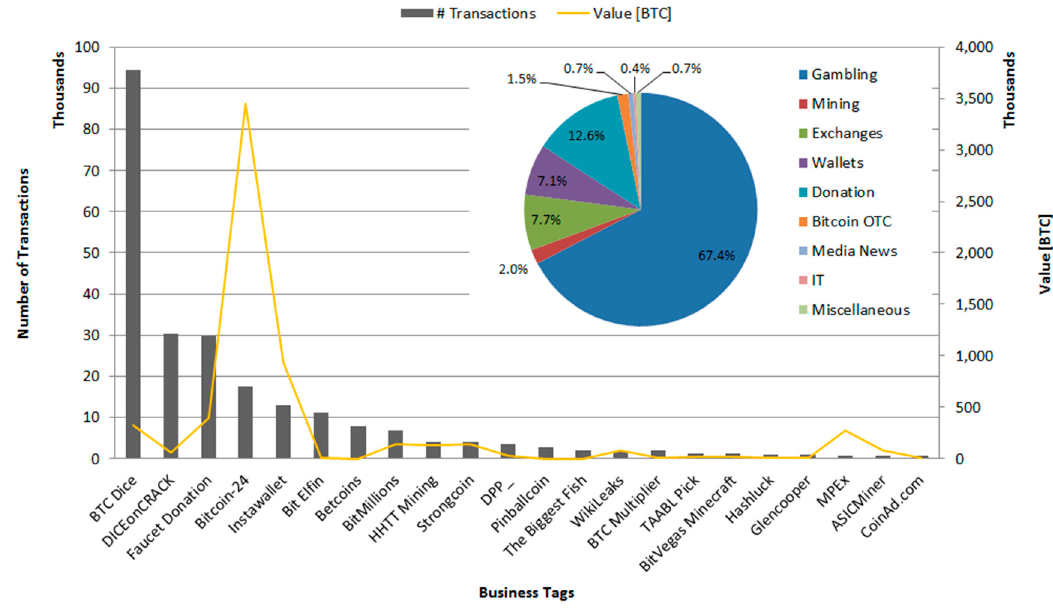
Figure 7. Top 25 Businesses (# Transactions).